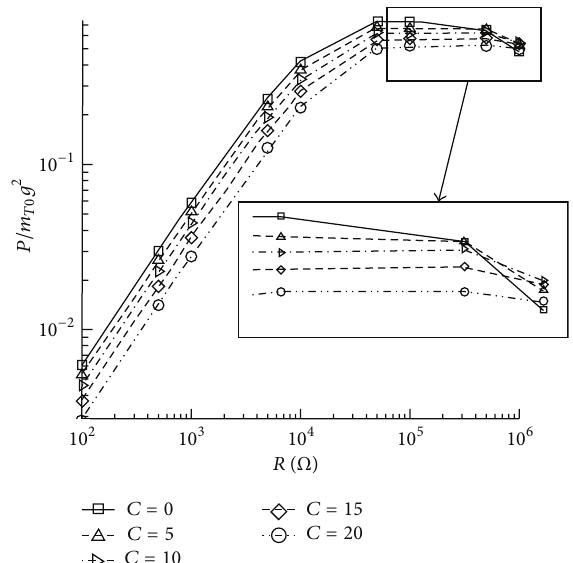
Figure 14: Tapering and electric resistance effects on bimorph with series